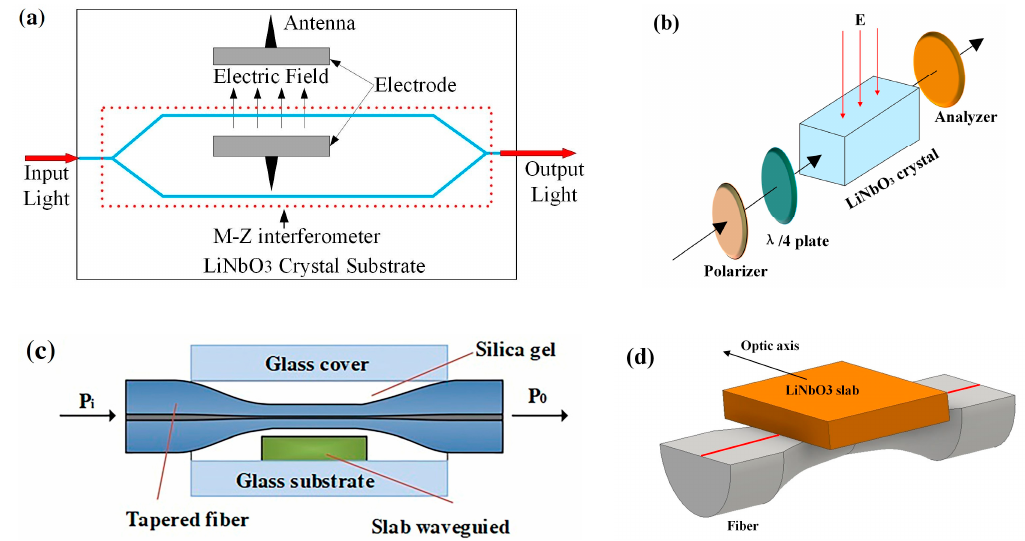
Figure 11. ( a ) Sensing area of electric field sensor based on Mach-Zehnder interferometer and LiNbO 3 [80], ( b ) sensing unit based on Pockels effect of LiNbO 3 [84], ( c ) sensor probe structure of tapered fiber and waveguide [85], ( d ) sensor head configuration of D-shaped fiber and LiNbO 3 slab [89]; permission conveyed through the Copyright Clearance Center, Inc.